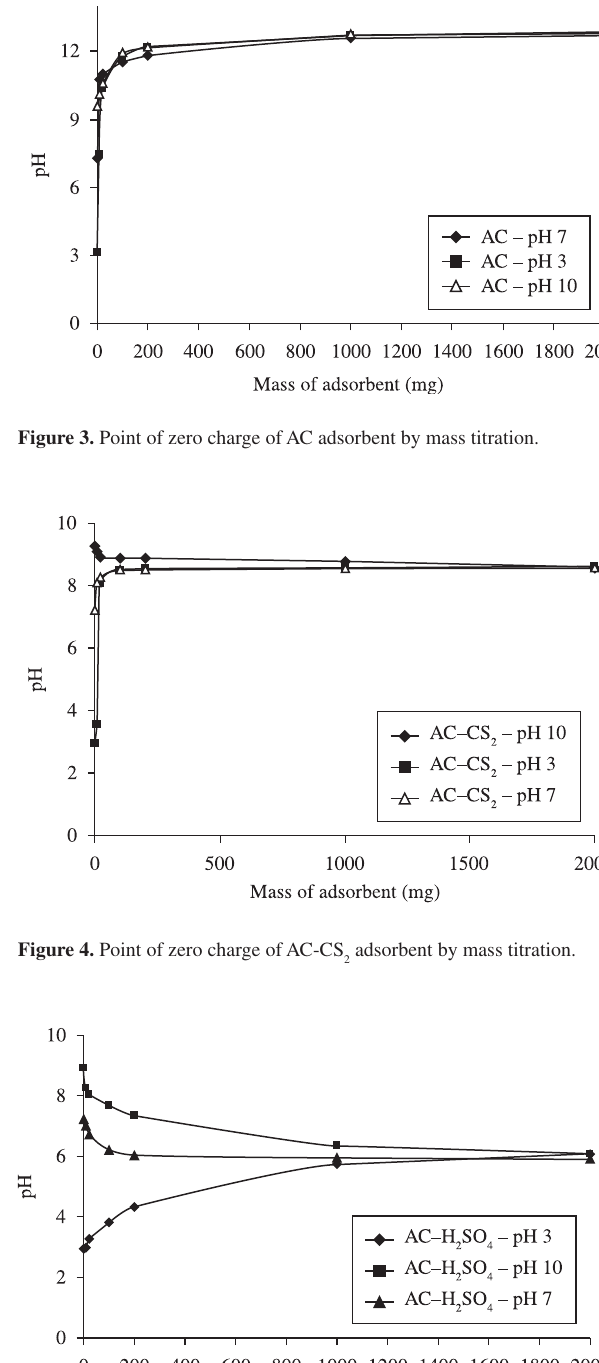
SO adsorbent by mass titration. 2 4